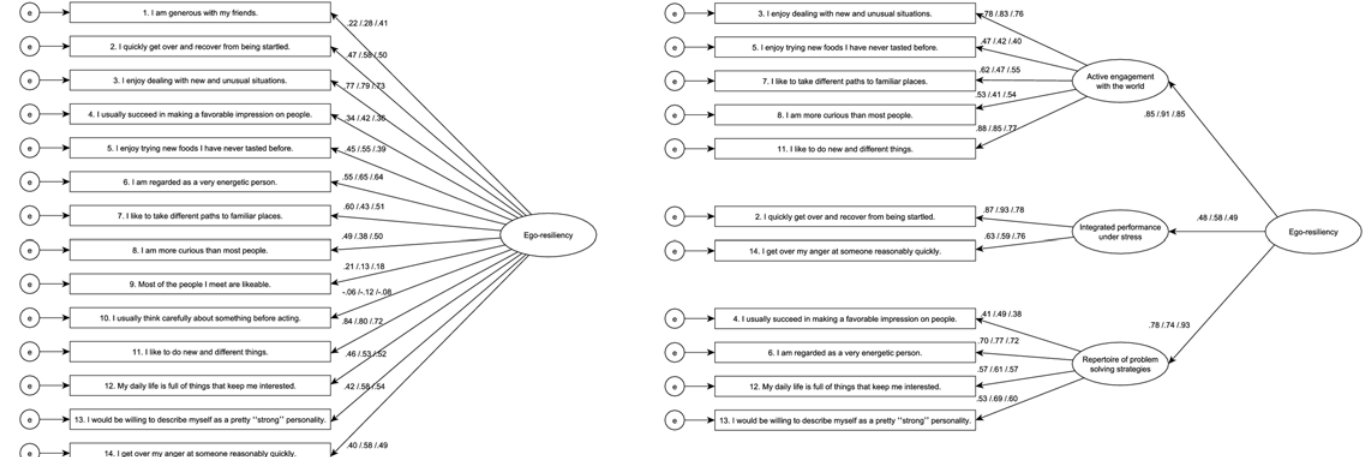
Fig 2. The CFA models of Ego-resiliency. Left side shows the original ER89 structure. Model 1: CFI = .849, RMSEA = .094, Model 7: CFI = .841, RMSEA = .097, Model 9: CFI = .846, RMSEA = .091. Right side shows the hierarchical ER11 structure. Model 4: CFI = .970, RMSEA = .055, Model 8: CFI = .968, RMSEA = .058, Model 10: CFI = .965, RMSEA = .057. One-headed arrows between the latent and observed variables show the standardized regression weights. The first value belongs to the Training Sample, after the slash the second value refers to the Test Sample. After the final slash the values of Test Sample 2 are noted.